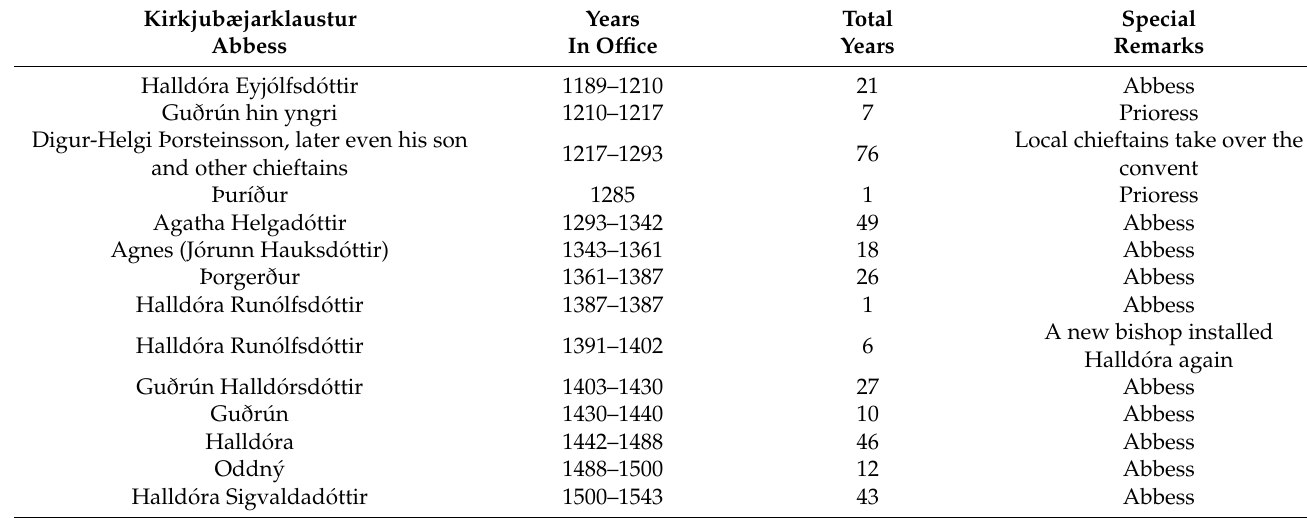
Table 1. The abbesses and prioresses of Kirkjubæjarklaustur.